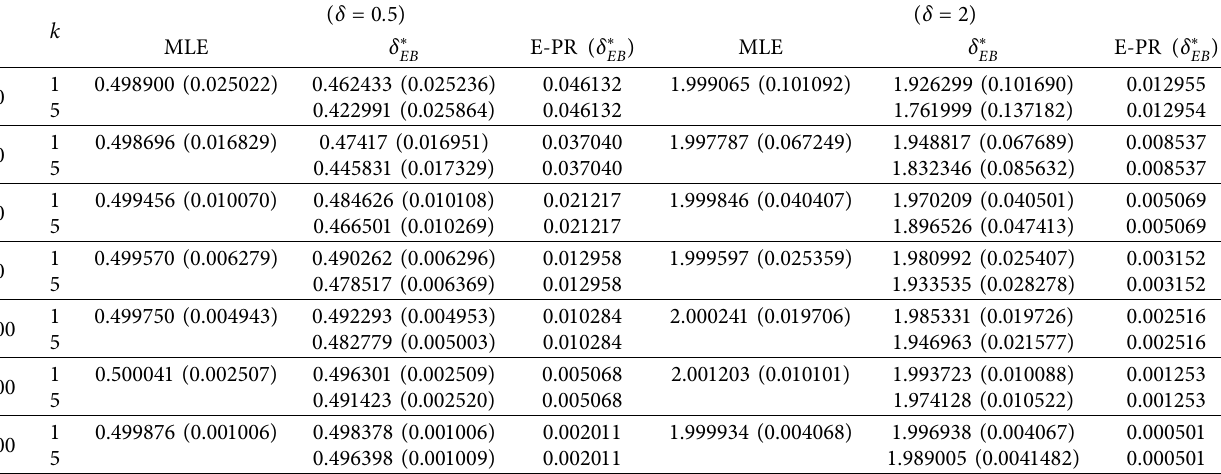
Table 3: E-B and E-PR estimates of STLF.